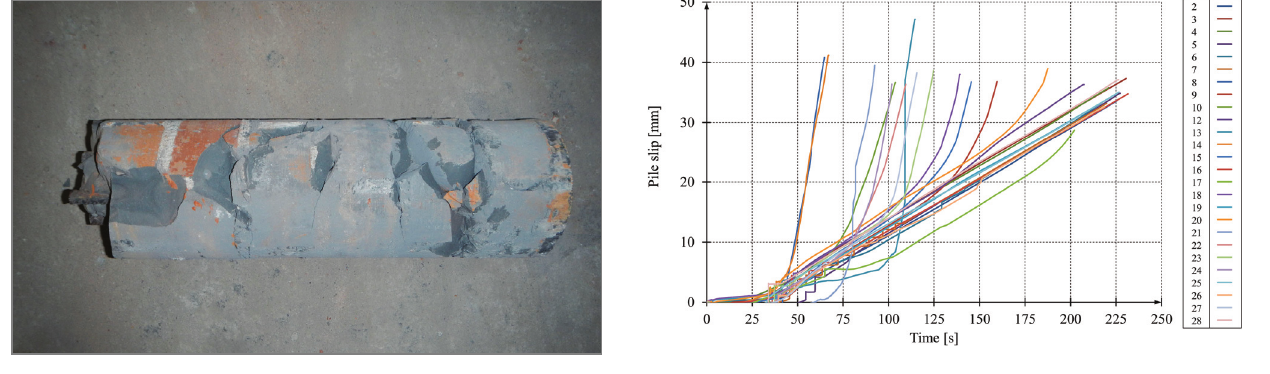
Photo 8a Fig. 12. Pile slip during loading of concrete